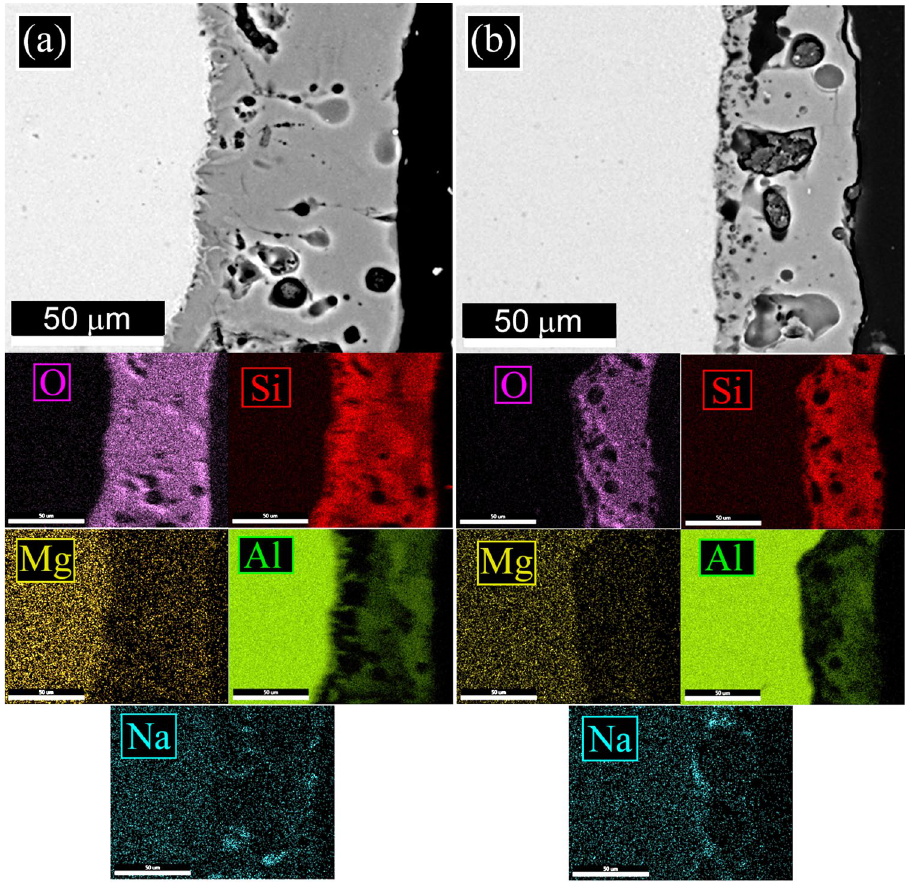
Figure 10. SEM–EDS elemental mapping of the cross-sections of the samples after PEO treatment: as printed sample ( a ) and annealed sample ( b